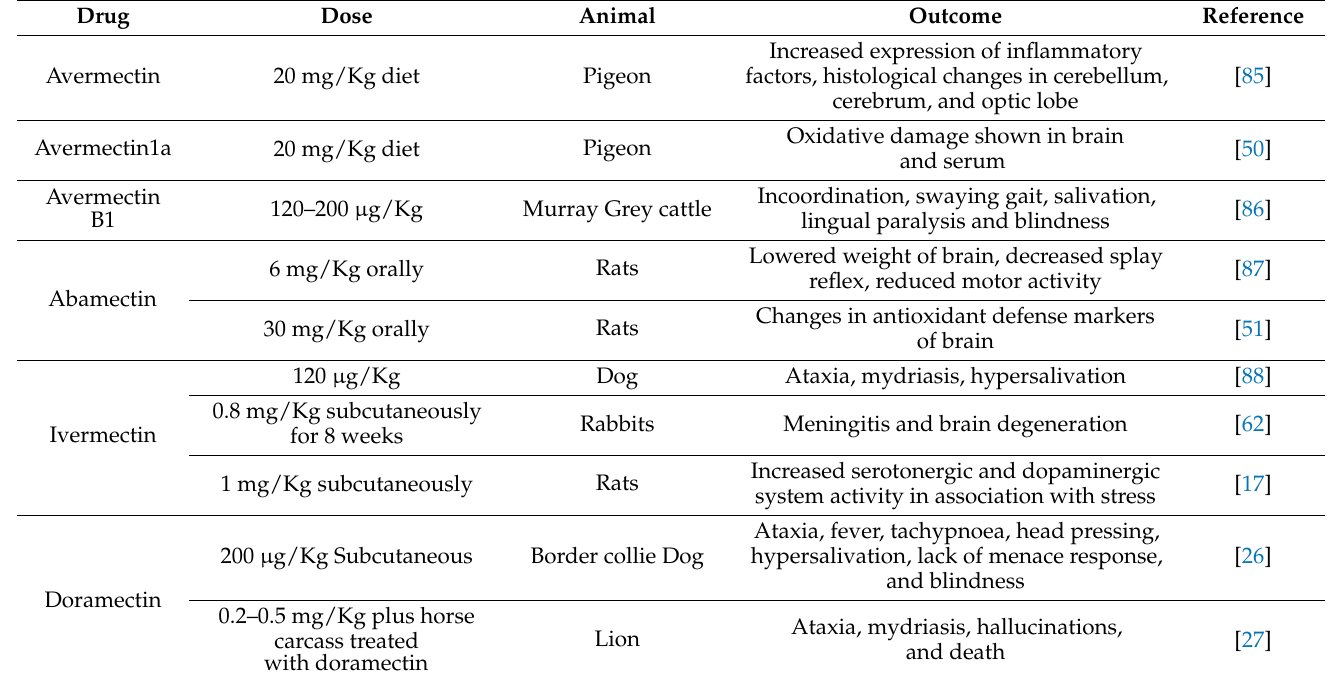
Table 3. Neurotoxic avermectins along with dose, animal and